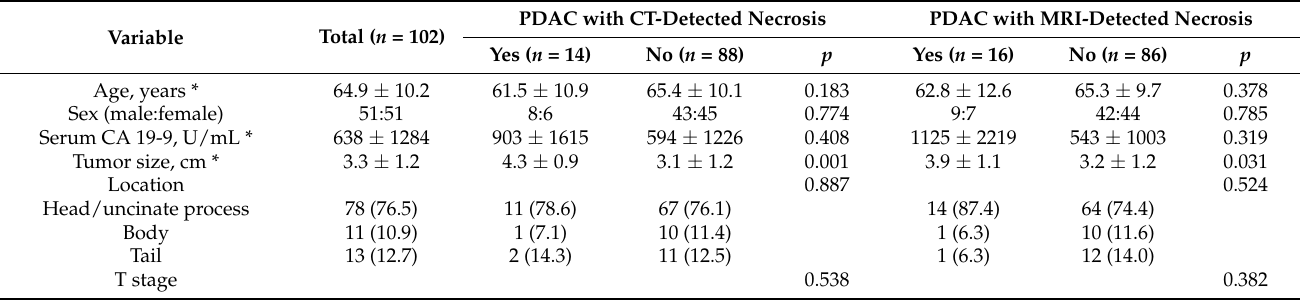
Table 1. Summary of clinical, pathological, and radiological findings of PDAC